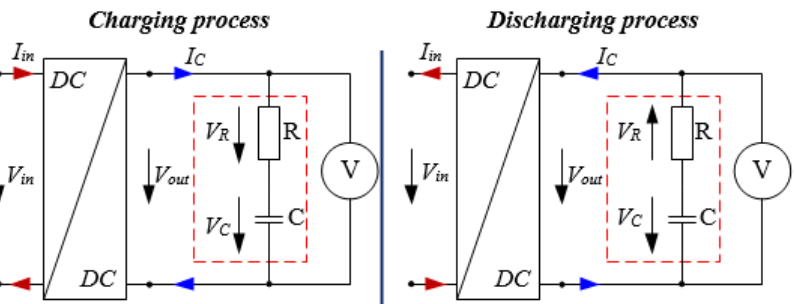
Figure 6. Charging and discharging circuits in SC series connection for theoretical analysis.